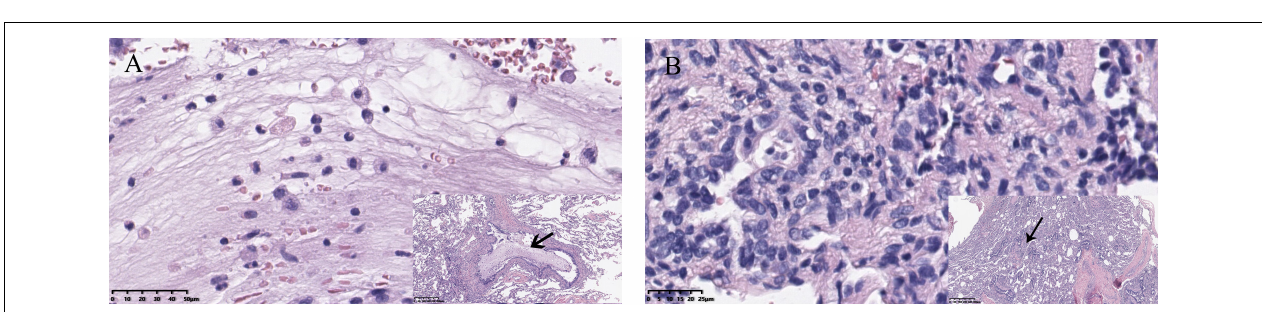
FIGURE 2 | (A) A typical CPAM patient with an abscess in the lesion. (B) Pleural adhesion in a 7-year-old asymptomatic CPAM patient. These two pictures showed the special situations in asymptomatic CLMs patients.